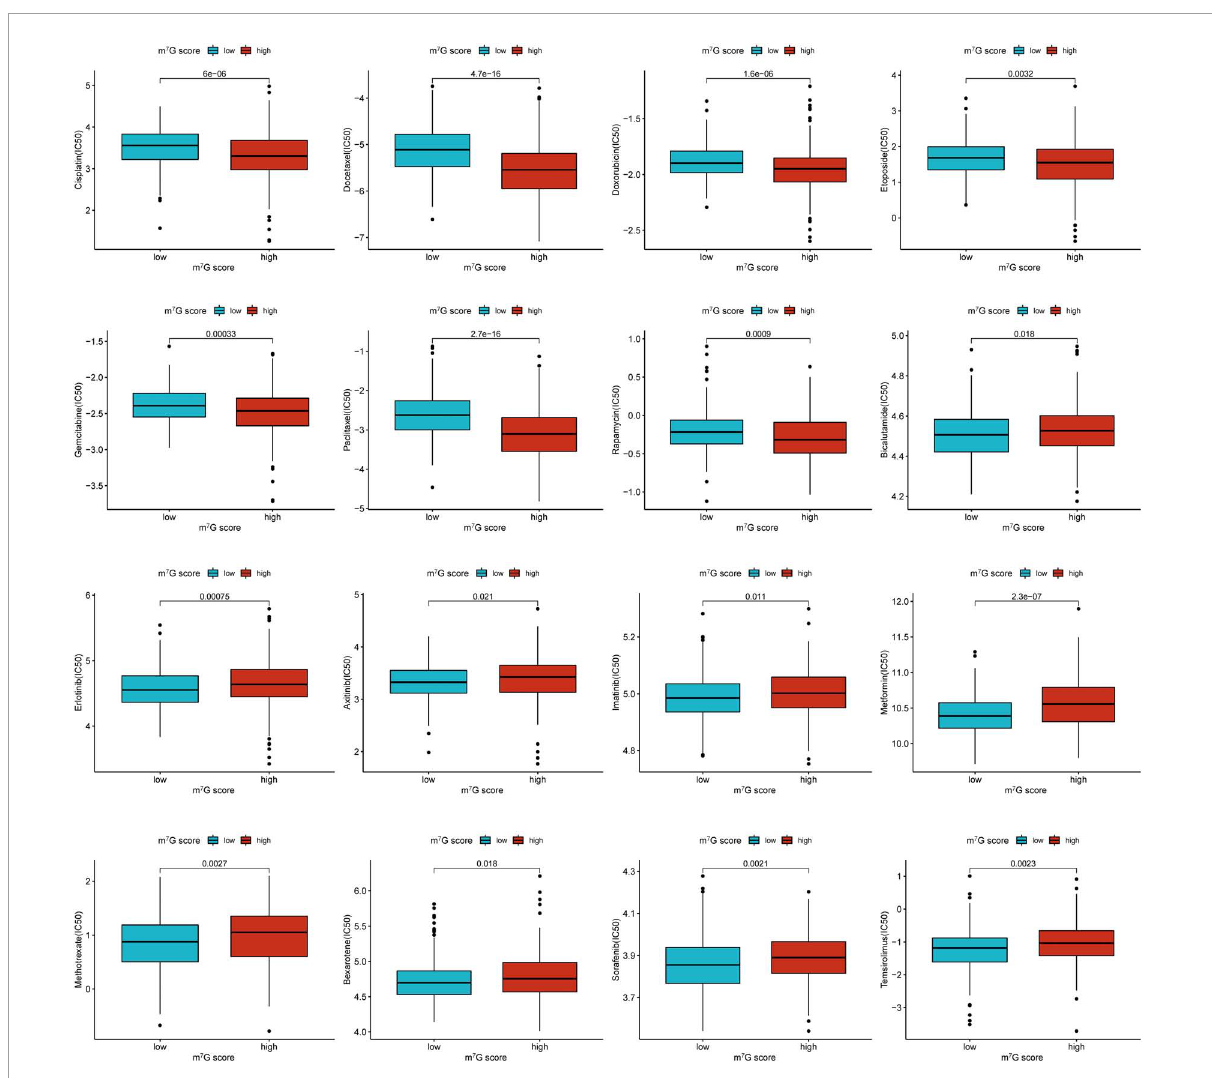
FIGURE13 Comparison of drug sensitivity between low and high m 7 G score